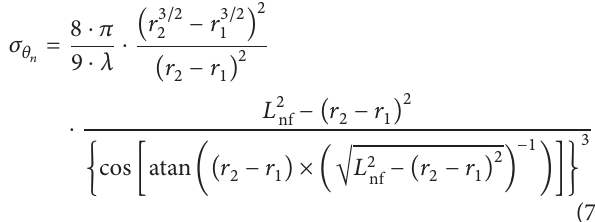
Figure 9: Comparison between the RCS values of the mast obtained from POfacets tool (blue line) and from the TSR simplified model (red dotted line) (turbine model 1 at 3.08